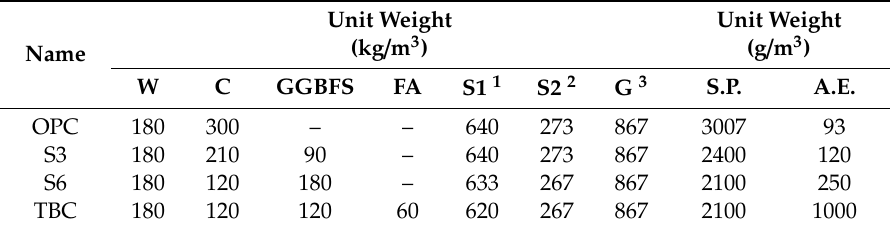
Table 2. Concrete mix proportion according to an experimental level.